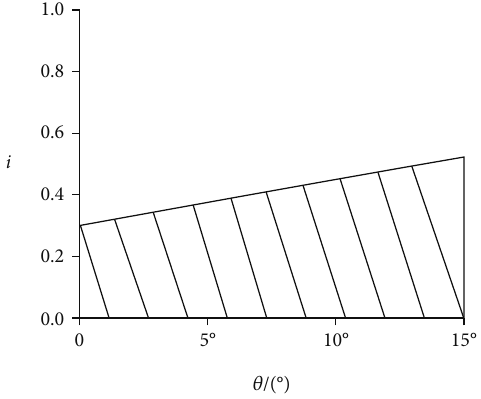
Figure 5: Relationship between degree of fracturing i and angle of rotation θ .